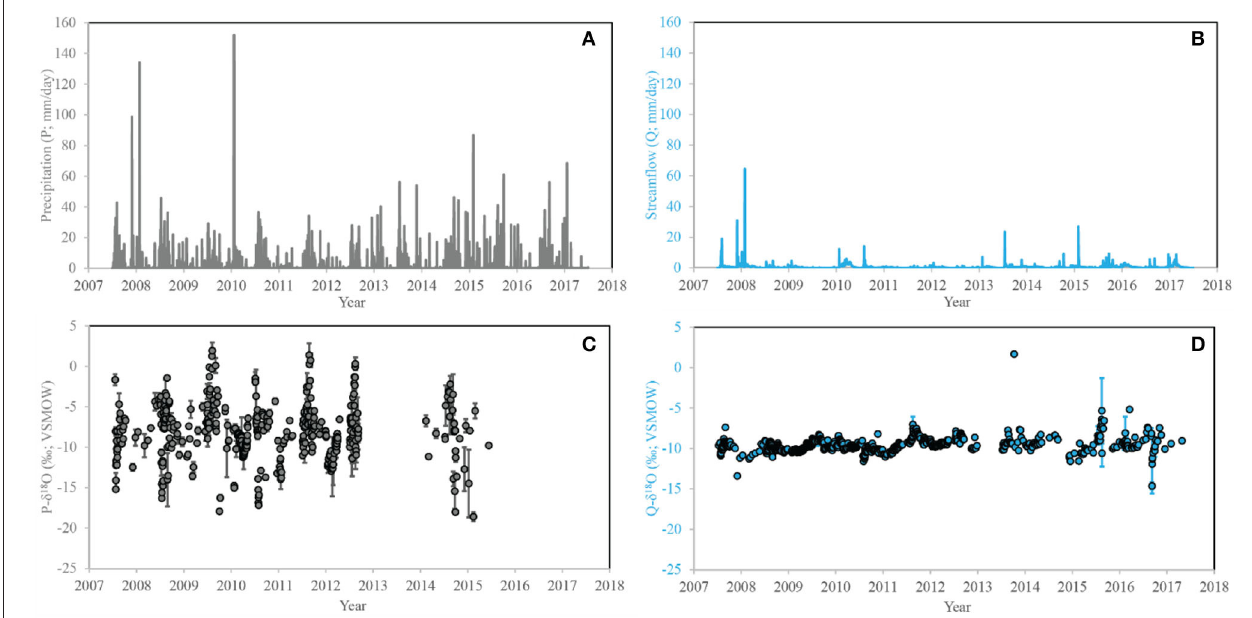
FIGURE 2 | Timeseries plots of daily precipitation [P; (A) ]; streamflow [Q; (B) ]; δ 18 O in P (C) and Q (D) from water year (WY) 2008 through WY 2017. The error bars in (C,D) show one standard